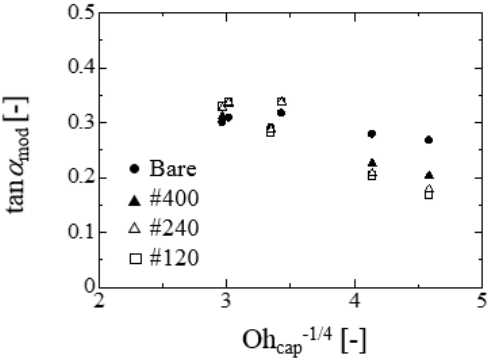
Figure 13. Relationship between tan α mod and Oh cap − 1/4 .